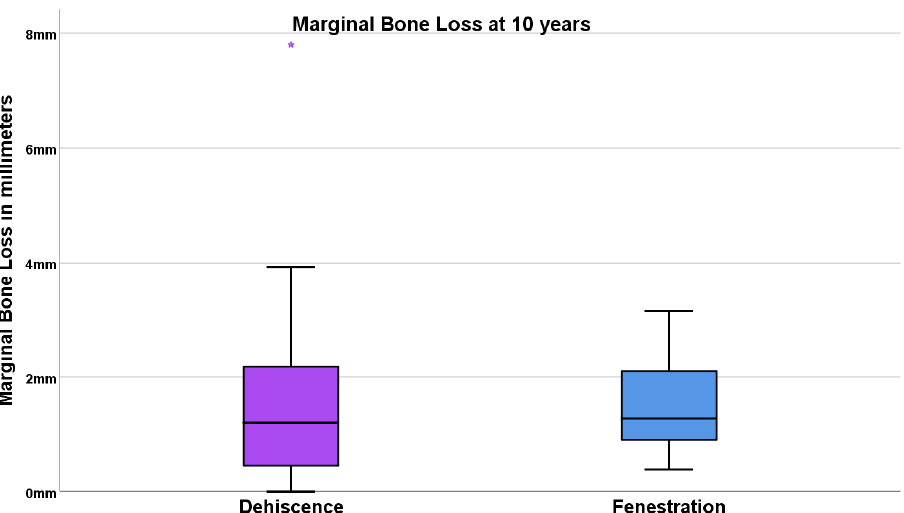
Figure 6. Boxplot illustrating the marginal bone loss at 10 years in both groups. The lower box edge represents 25% of the sample; the upper box edge represents 75% of the sample; the horizontal black line represents the median; star represents an outlier value. Note that the median in both groups was localized below 1.3 mm at 10 years.